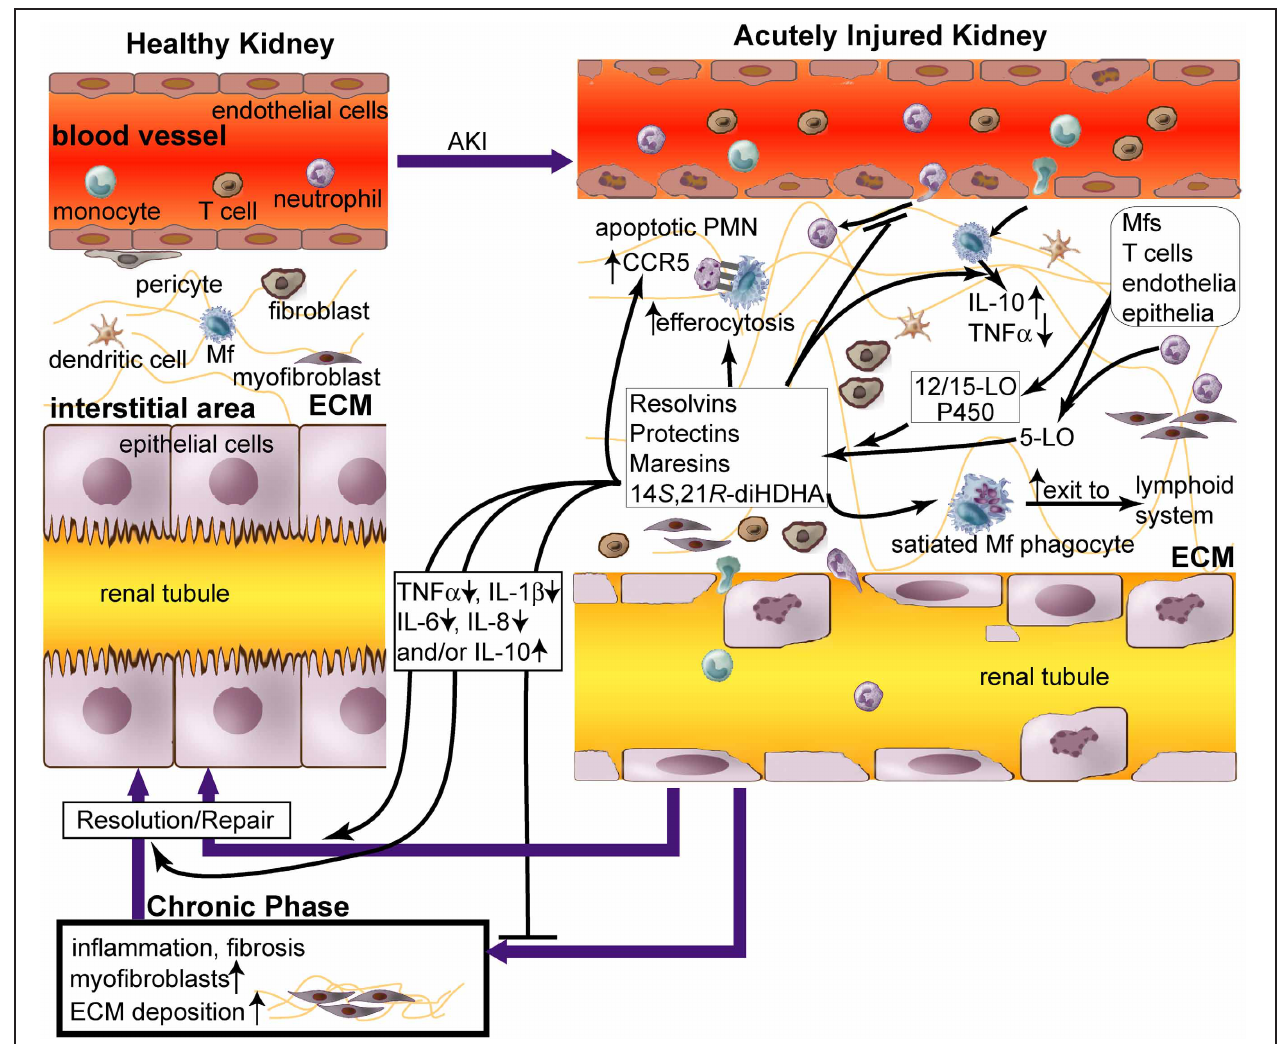
FIGURE 1 | Role of lipid mediators, resolvins and protectins in inflammation resolution in acute renal injury (AKI). AKI causes (1) damage of renal vascular endothelium; (2) diapedesis of neutrophils and monocytes through endothelium; (3) accumulation of neutrophils, macrophages (Mfs), dendritic cells (DCs), T cells, fibroblasts, and myofibroblasts in renal tissue; and (4) apoptosis and necrosis of tubular epithelium. Impaired inflammation resolution that occurs during AKI leads to chronic fibrosis [i.e., excessive extracellular matrix (ECM, as light-green lines) produced by myofibroblasts and other cells in the kidneys] and ultimately chronic renal failure (Bonventre and Yang, 2011; Serhan and Petasis, 2011). Although leukocytes cause tissue damage when activated to inflammatory phenotypes by AKI in the initial phase, they could promote inflammation resolution and tissue repair when modulated by pro-resolving lipid mediators, including resolvins and protectins. Resolvins, protectins, maresins, and 14 S ,21 R -diHDHA are produced by 12/15-lipoxygenase (LO), p450, and/or 5-LO, in trans-cellular or